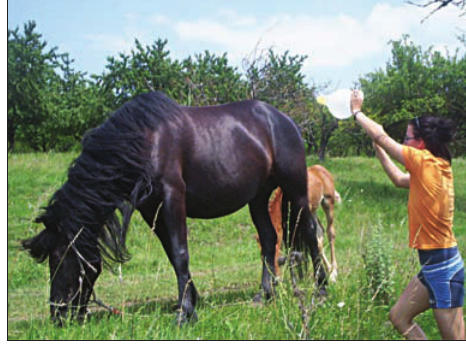
Fig. 2. Popping balloon